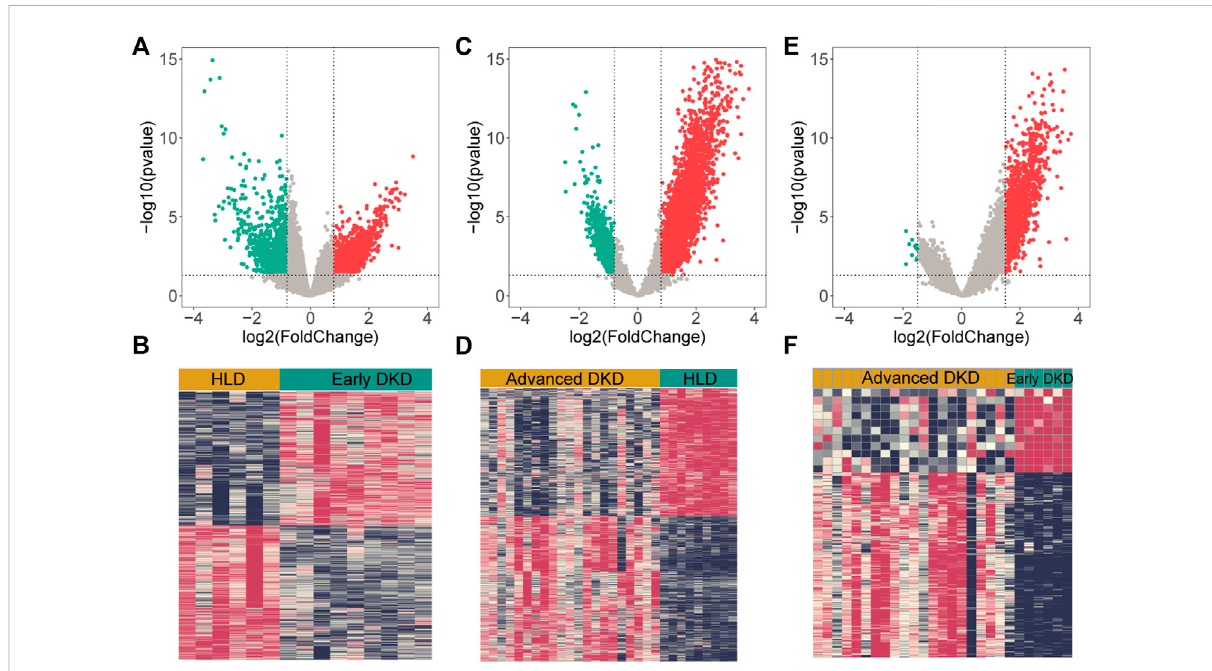
FIGURE 3 The volcano and heatmap plots of differentially expressed genes (DEGs). Red points indicate up-regulated genes, green points indicate down- regulated genes, and gray points indicate genes with no signi fi cant difference. (A,B) DEGs from 9 healthy living donors and 6 early stage DKD samples. (C,D) DEGs from 9 healthy living donors and 21 advanced stage DKD samples. (E,F) DEGs from 6 early stage DKD and 21 advanced stage DKD samples. HLD, healthy living donor; DKD, diabetic kidney